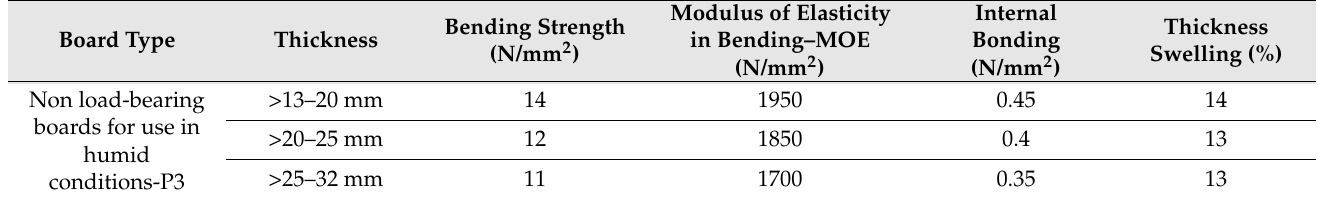
Table 3. Requirement Values for Type P3 Board (extracted from BS EN 312-2010).